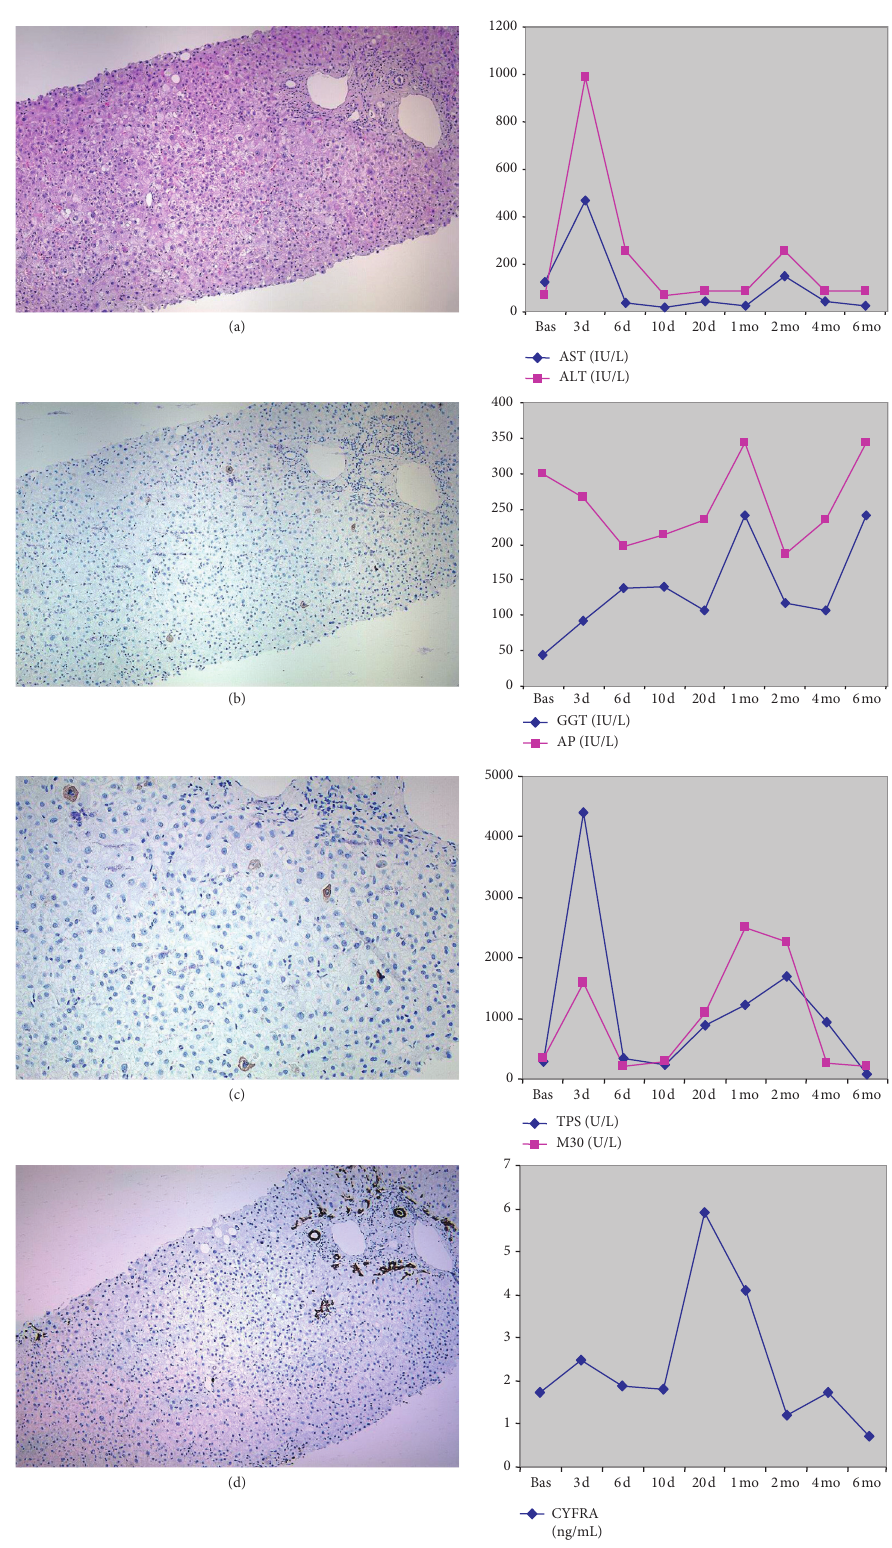
Figure 4: Individual data from Patient 10, who had HCV recurrence after liver transplantation. Liver biopsy (left panels) was performed 3 months after transplantation. (a) Hematoxylin-eosin staining revealed typical signs of HCV recurrence. (b and detail in c) Immunostaining for the M30 neoepitope revealed positivity in apoptotic hepatocytes throughout the liver lobule. (d) Immunostaining for K19 revealed only the normal positivity in bile ducts. Time-course changes in standard biochemical markers (AST, ALT, GGT, and alkaline phosphatase (AP)) and serum keratins (TPS, M30, and CYFRA 21-1) are presented in the right panels. d, day; mo,